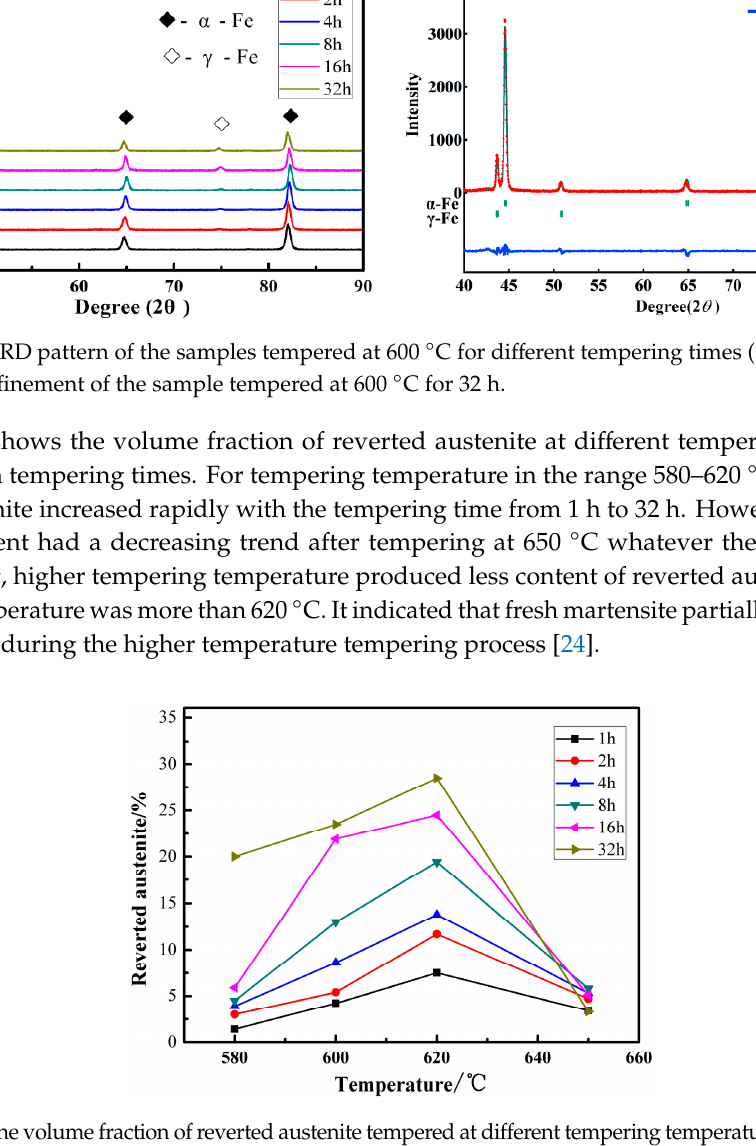
Figure 3. TEM micrographs of reverted austenite in the sample tempered at 620 °C for 32 h, ( a ) bright field image; ( b ) dark field image and ( c ) SAED pattern of the reverted austenite.